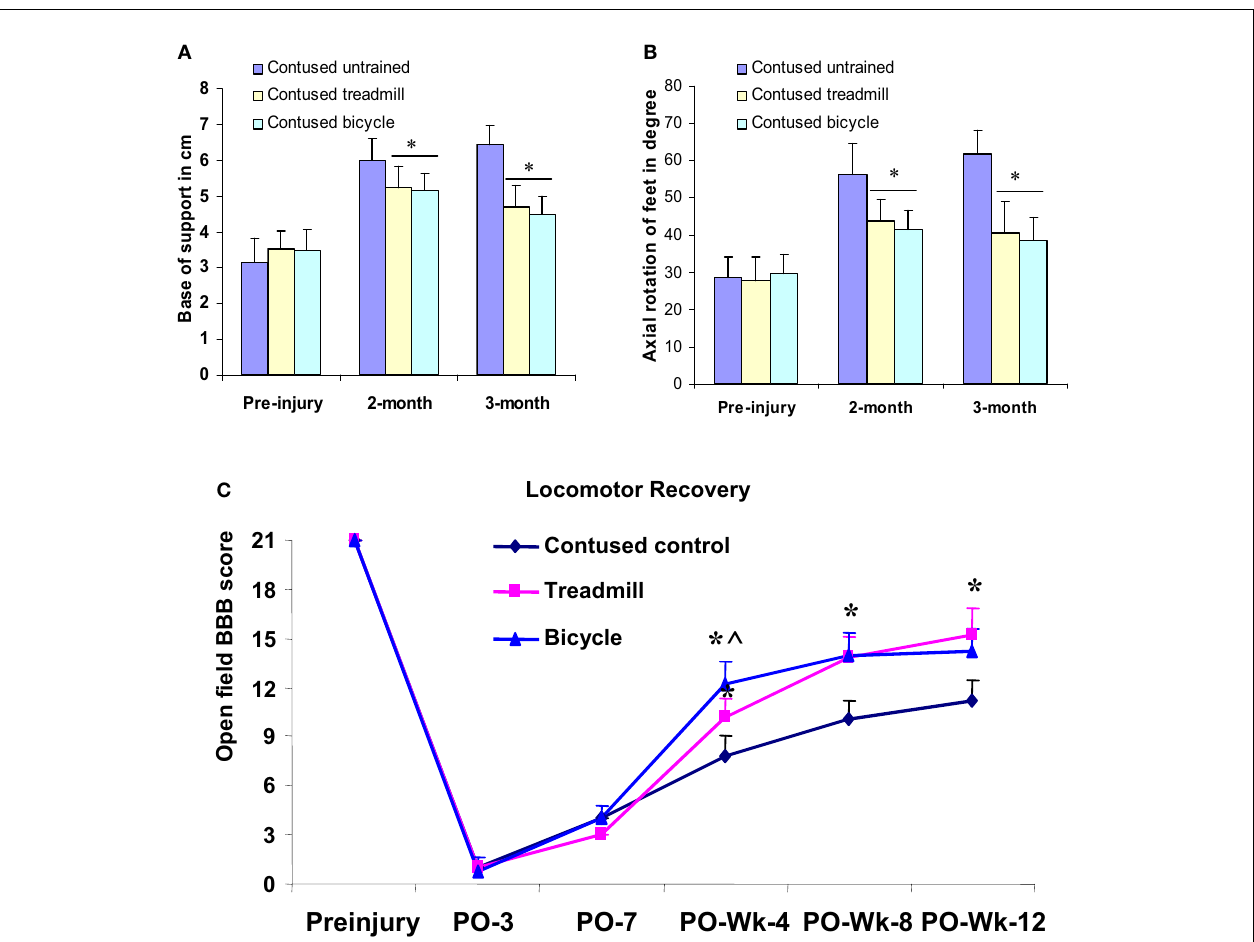
types of training significantly improved locomotor recovery compared with untrained controls (C) .The bicycle training group demonstrated the greatest recovery at postop 4weeks, which is significantly different even compared with treadmill group. However, at postop 8weeks, both training groups showed similar recovery. * p < 0.05 compared with untrained contused group; ∧ compared with treadmill group